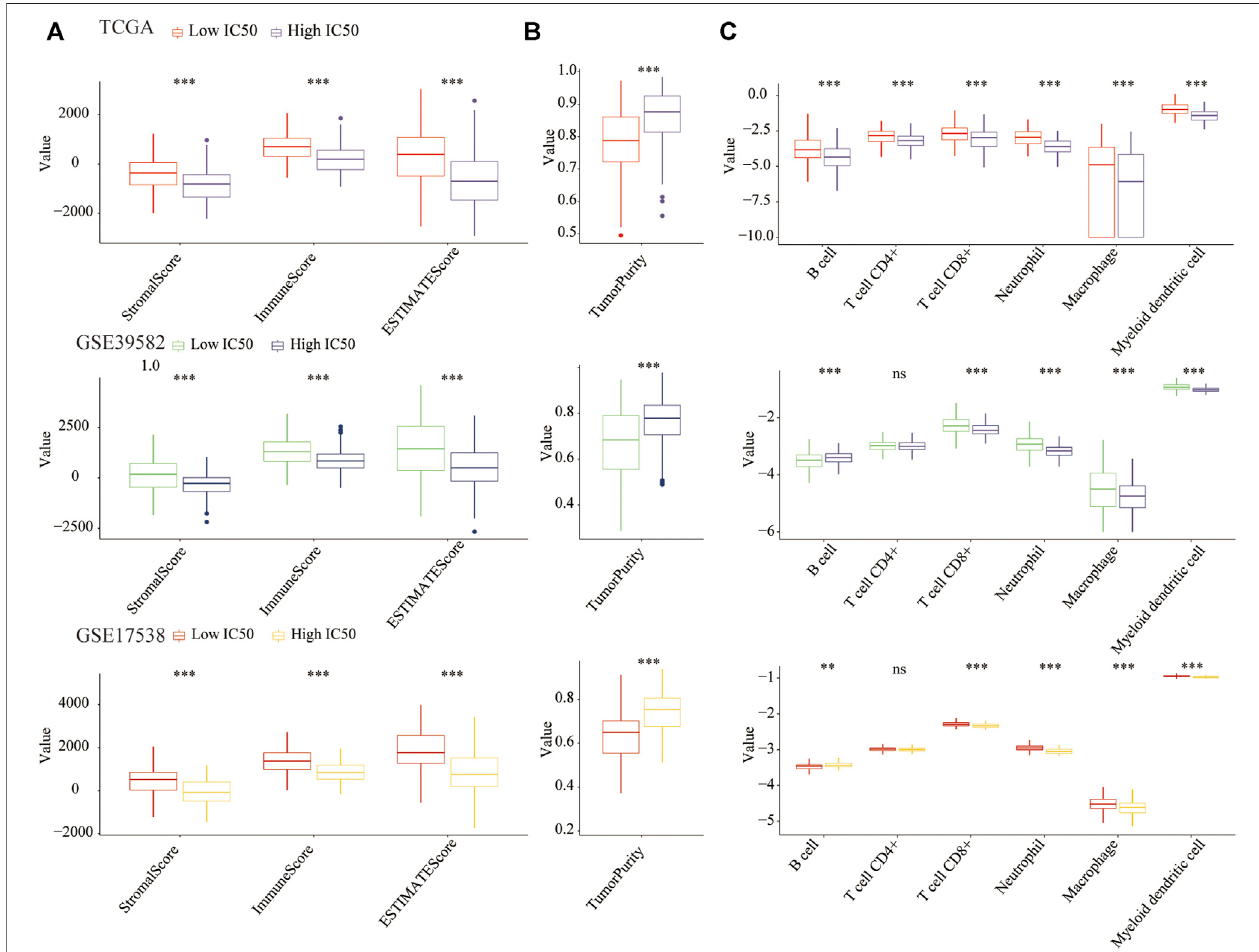
FIGURE 2 | The COAD tissues of the low-IC50 group were more like hot tumors. (A) The stromal, immune, and ESTIMATE scores of the low-IC50 group were signi fi cantlyhigherthanthoseofthelow-IC50group. (B) ThetumorpurityofCCtissuewassigni fi cantlylowerinthelow-IC50group. (C) Comparisonofabundanceofsix kinds of tumor in fi ltrating immune cells between low- and high-IC50 groups. ** p < .01, *** p < .001.